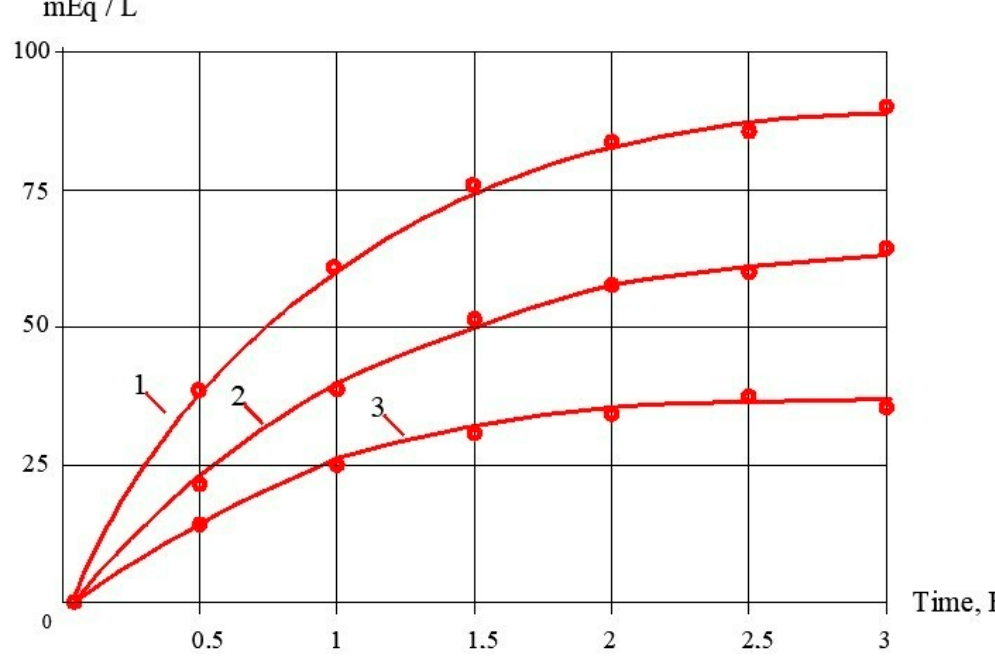
Figure 11. Dependencies of calcium ionic concentration in citric acid cleaning solution on time: 1—first cleaning; 2—second cleaning; 3—third